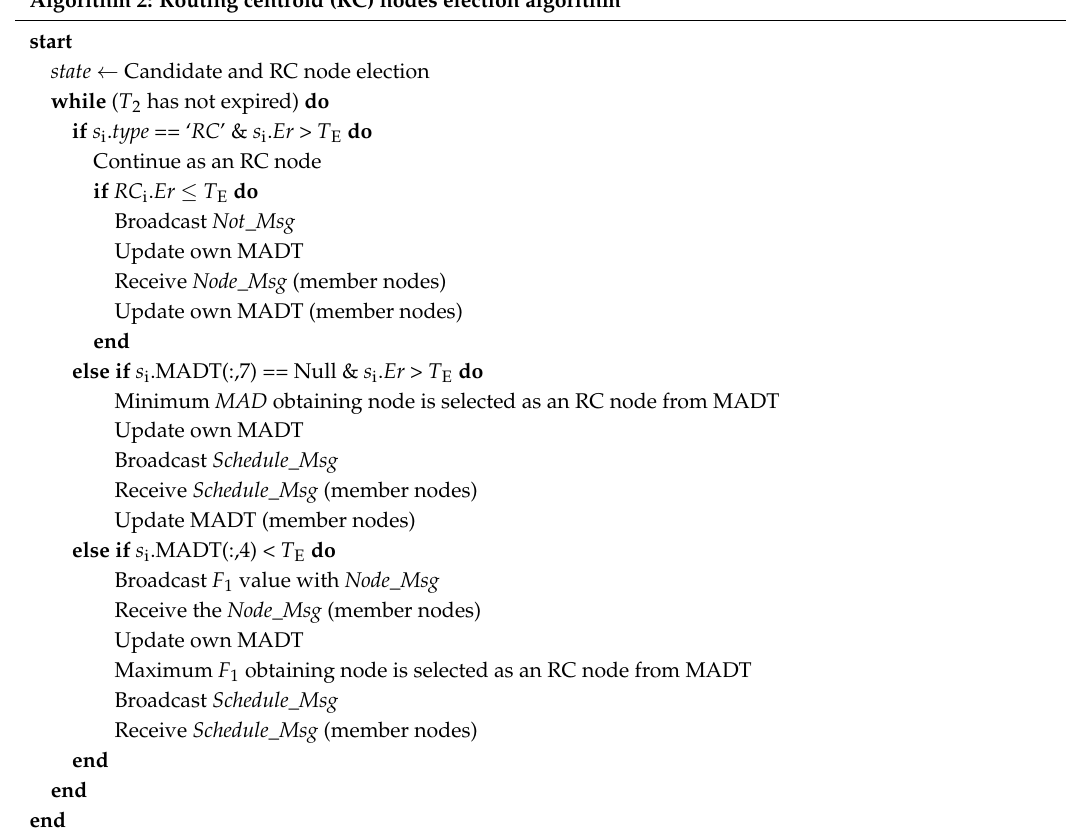
Algorithm 2: Routing centroid (RC) nodes election